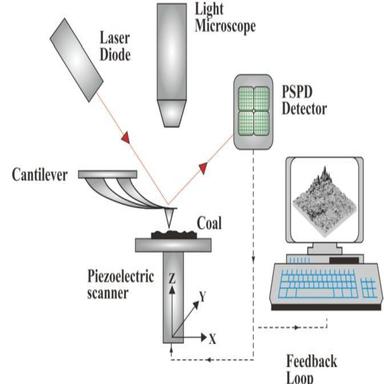
A schematic of the AFM instrument.